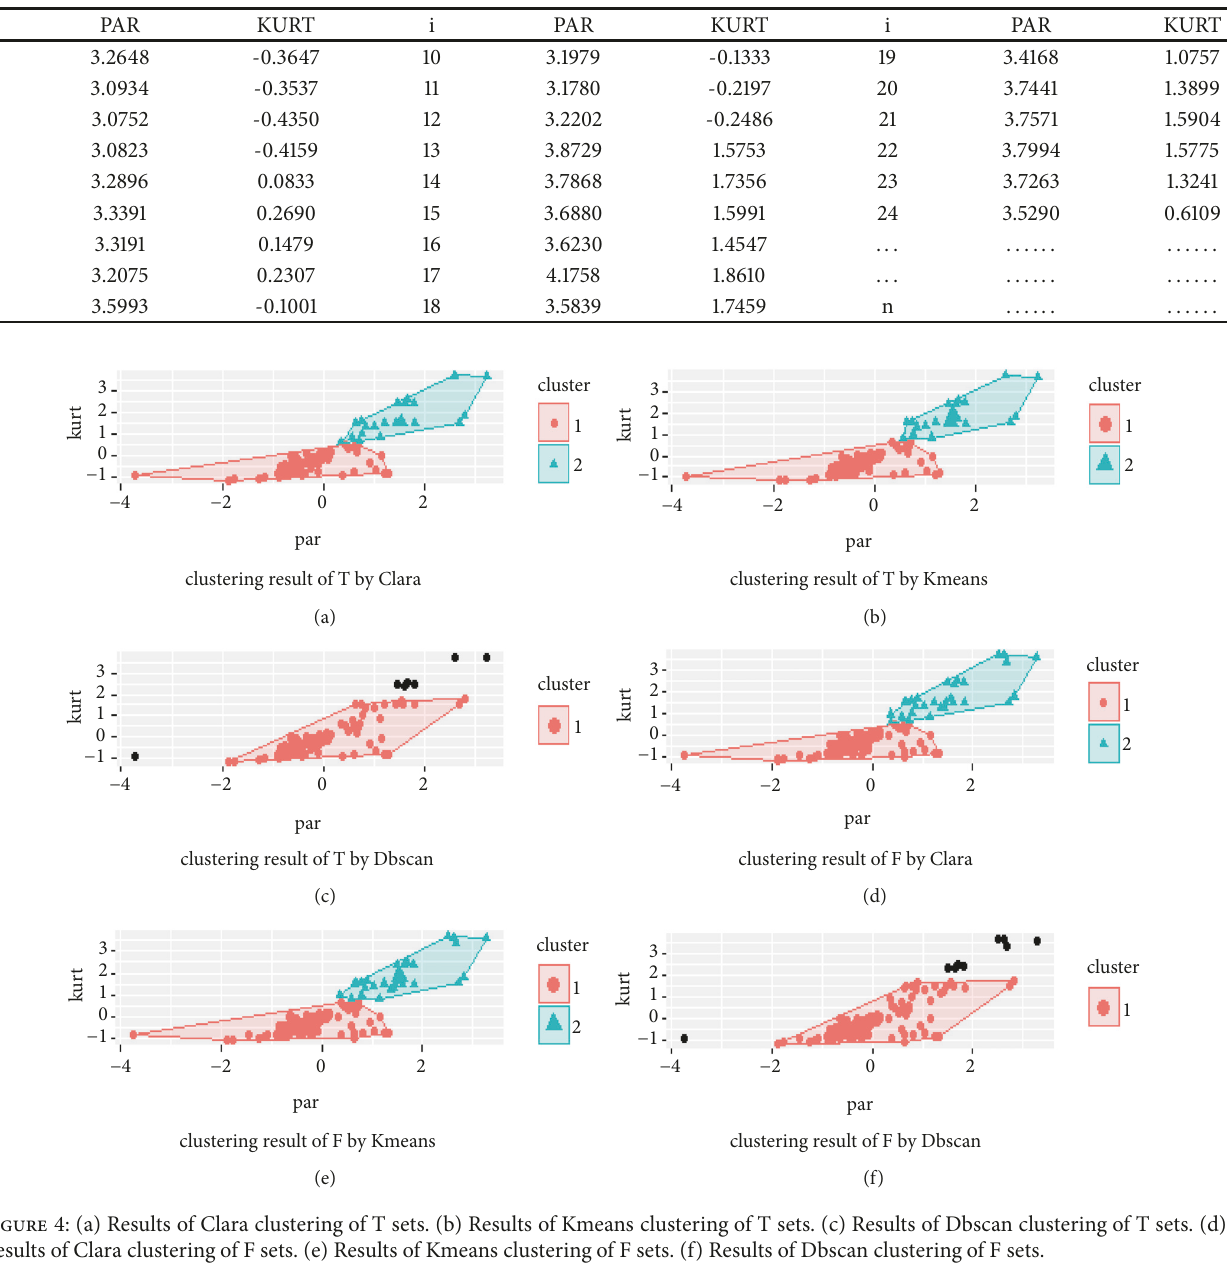
Table 2: DE eigenvector table.